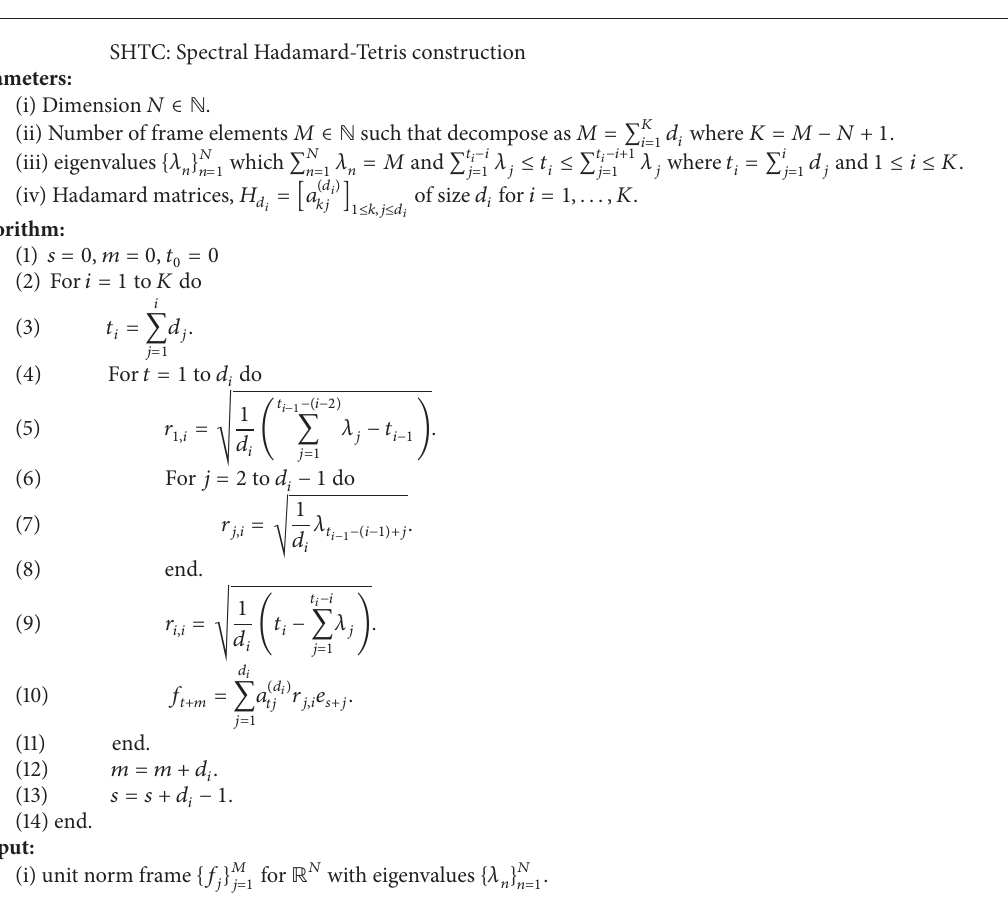
Algorithm 3: The SHTC algorithm for constructing a unit norm tight frame with 𝑀 elements for R 𝑁